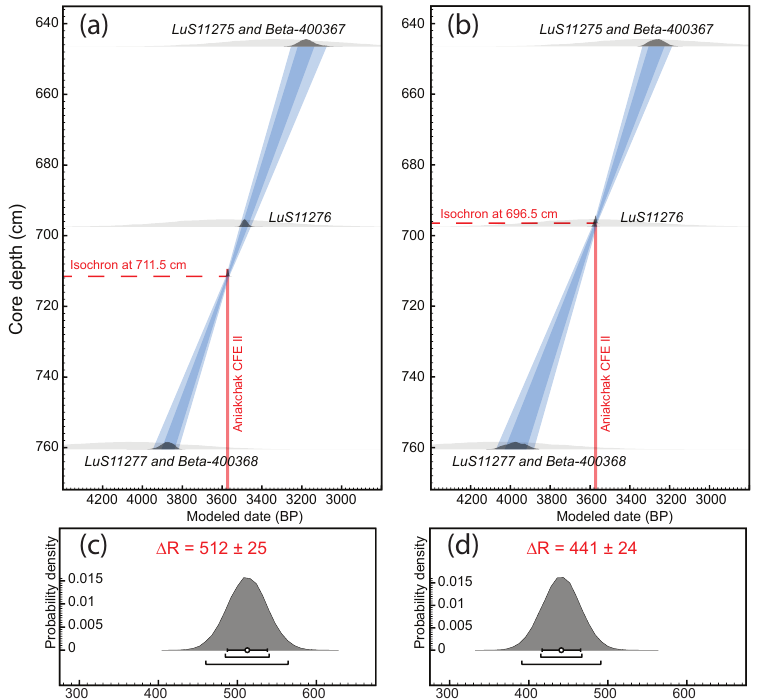
Figure 5. Calculation of marine reservoir age offset (cid:49)R , based on the placement of the isochron at different depths. (a, b) Age–depth models for the lower part of Core 2PC, based on maximum (a) and minimum (b) depth levels of the Aniakchak isochron. (c, d) Probability distribution of the posterior (cid:49)R values for the maximum (c) and minimum (d) isochron